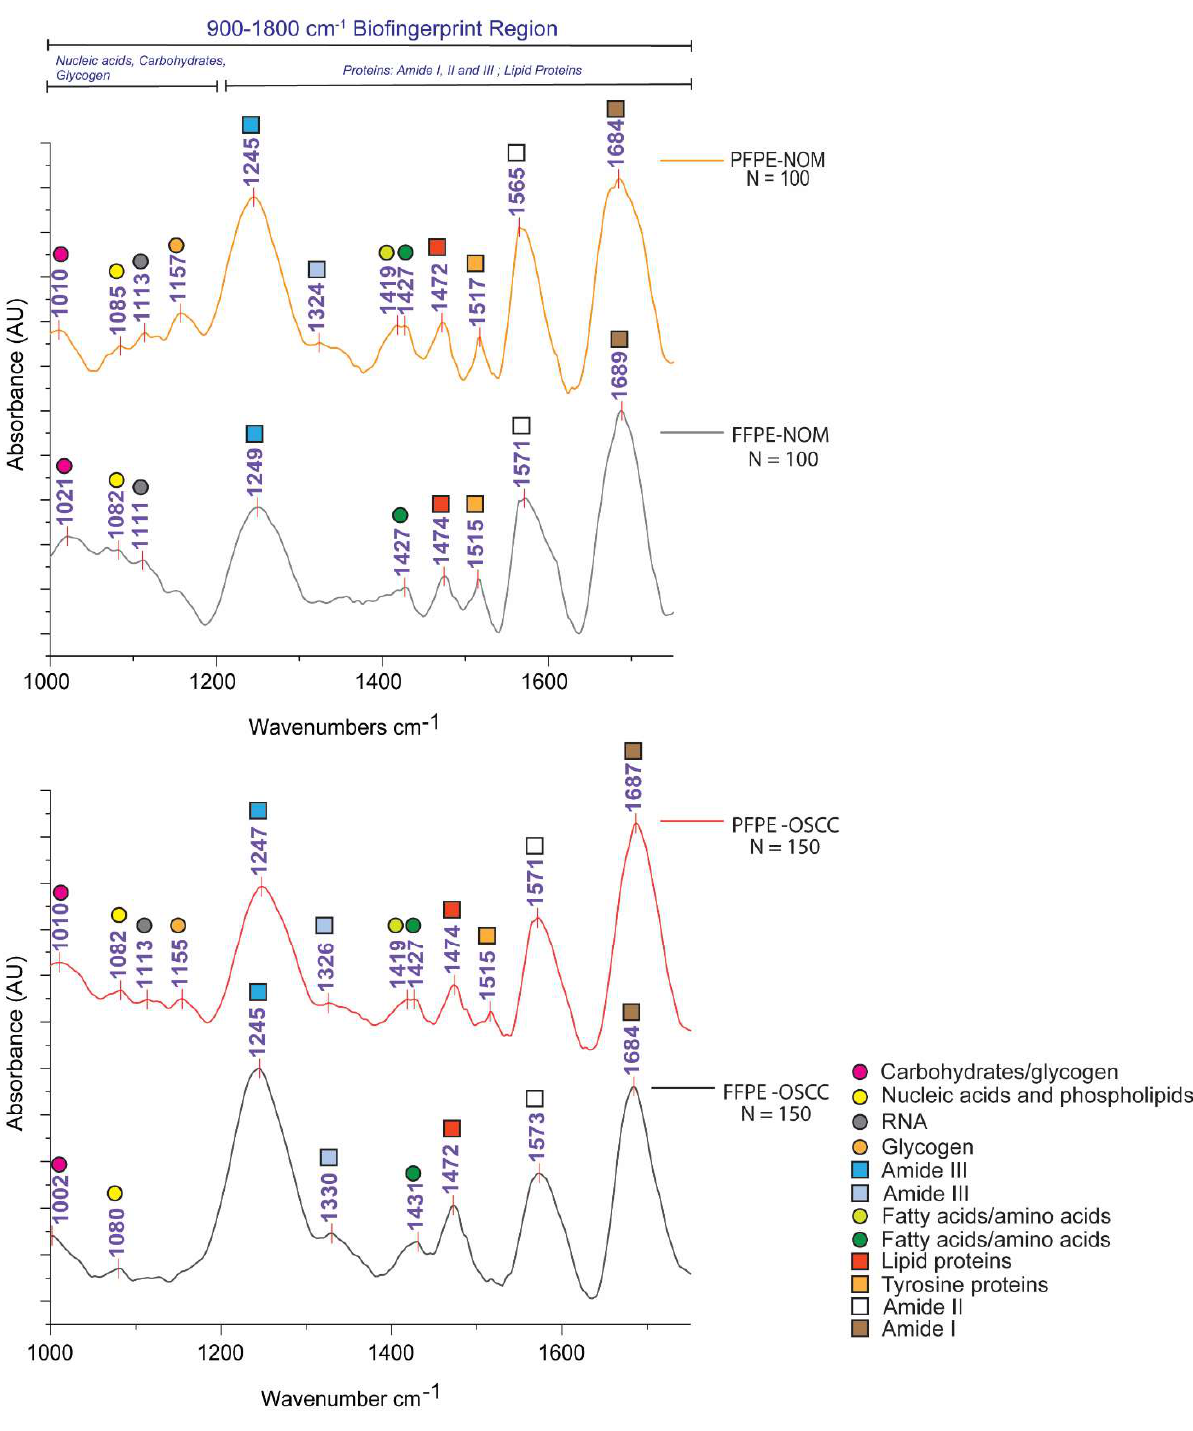
Figure 5. Average FTIR spectra from PFPE-NOM, FFPE-NOM, PFPE-OSCC, and FFPE OSCC tissues depicting the biofingerprint region 900 cm −1 –1700 cm −1 . N spectra PFPE-NOM = 100; N spectra FFPE-NOM = 100; N spectra PFPE-OSCC = 150; and N spectra FFPE-OSCC = 150. Abbreviations: FFPE, formalin-fixed paraffin embedded; PFPE, PAXgene-fixed paraffin embedded; OSCC, oral squamous cell carcinoma; NOM, normal oral mucosa.